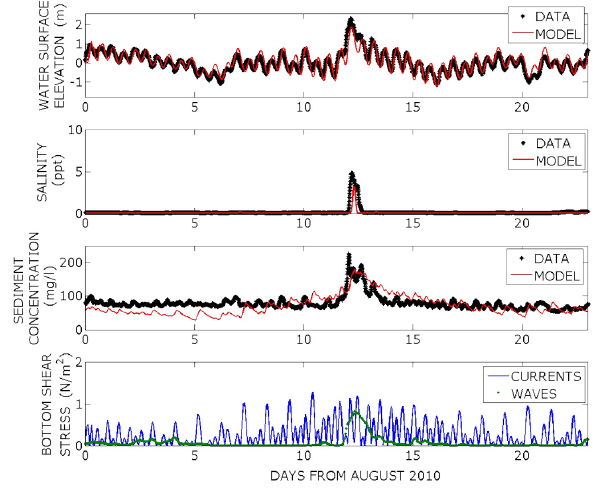
Fig. 2. Measured and modelled time series of water surface ele- vation (upper panel), salinity at mid depth (second panel), sedi- ment concentration at mid depth (third panel) and computed wave- induced and current-induced bottom shear stress (lower panel) at TO station during 23 days in August